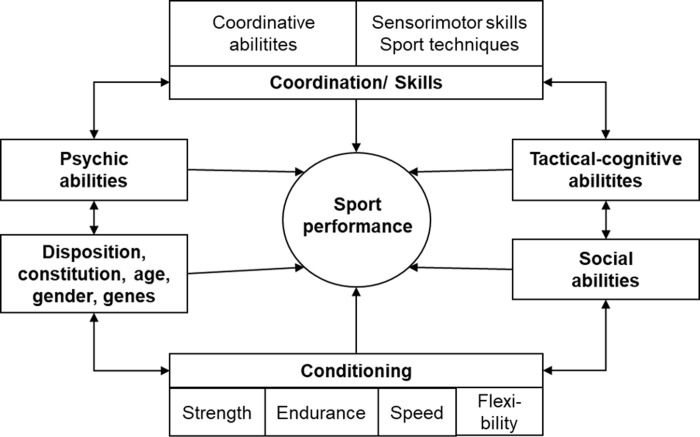
Generic model of sport performance [15].